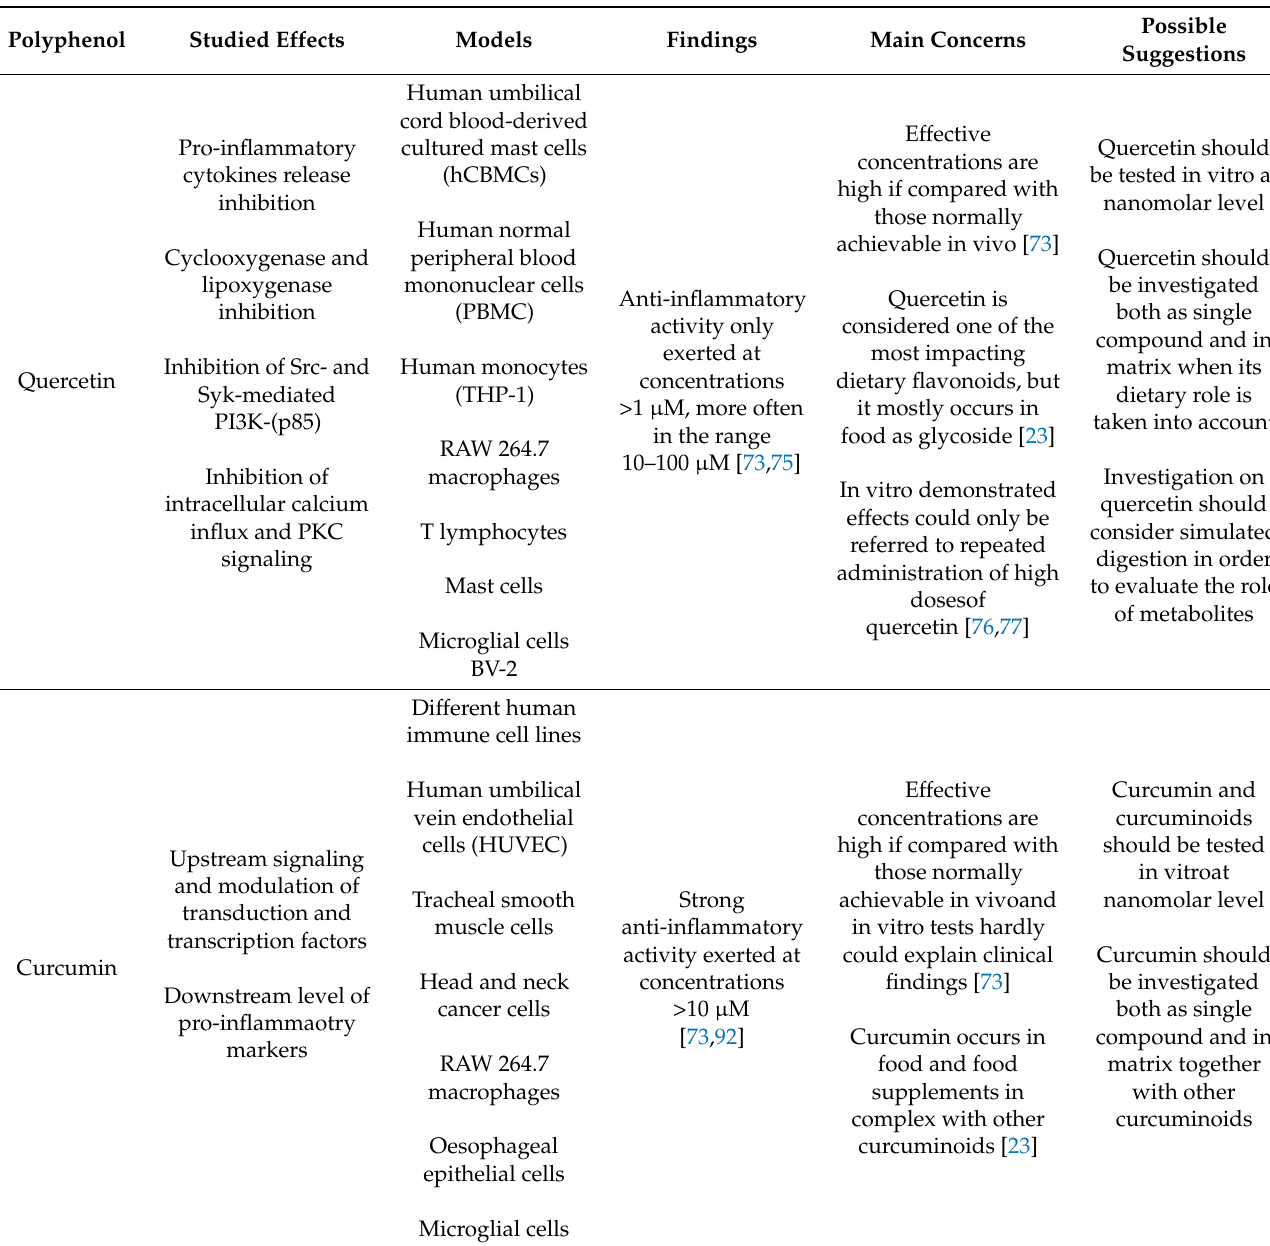
Table 2. In vitro anti-inflammatory activity of quercetin, curcumin and resveratrol: concerns and suggestions for a proper study of these poor available